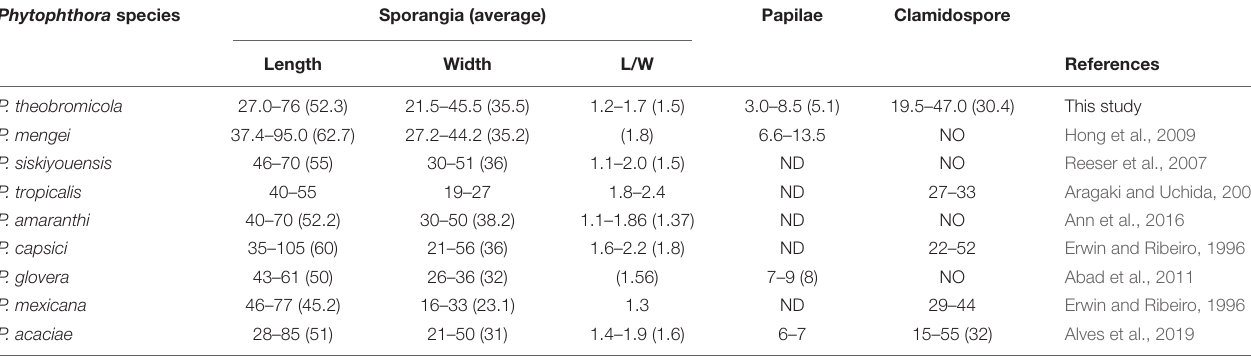
FIGURE 3 | Growth rates of Phytophthora species on different culture media. Colony diameter measurements are represented by dots, and the predicted profiles through a linear mixed-effects model are indicated by continuous line. Culture media are highlighted in blue (potato-dextrose-agar; PDA), red (carrot-agar; CA), green (2% malt-extract-agar; MEA), and purple (V8-juice-agar; V8A). TABLE 2 | Morphological characters and dimension relations of Phytophthora theobromicola compared to reference isolates of Phytophthora species from subclade 2b. Phytophthora species Sporangia (average) Papilae